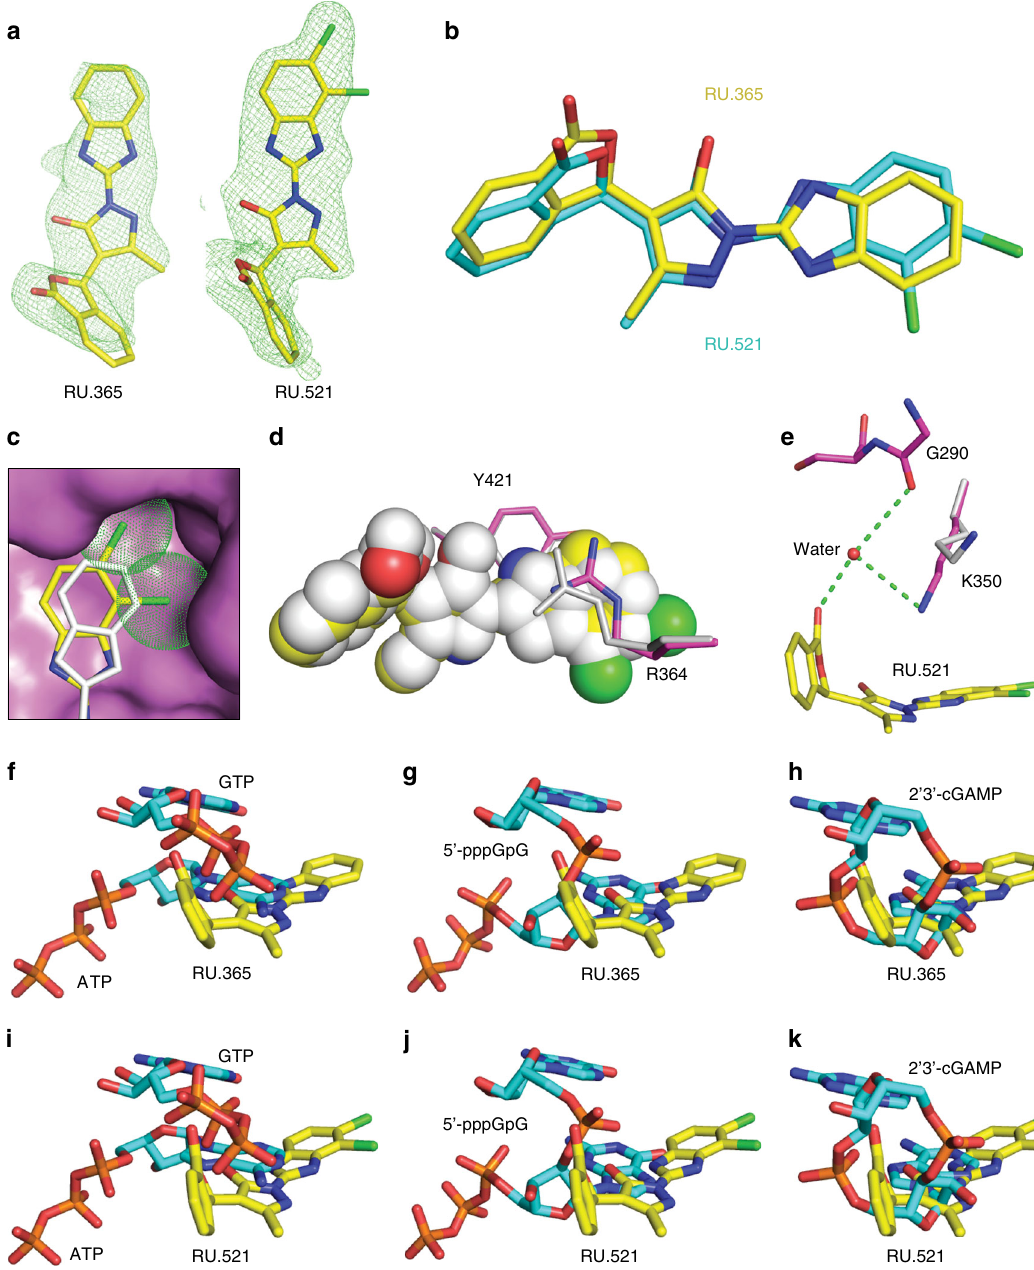
Fig. 3 A structural comparison of RU.365 with its derivative RU.521. a Omit Fo-Fc electron density ( green mesh ) of RU.365 and RU.521 contoured at 3 σ . b Superposition of structures of bound RU.365 ( yellow ) and RU.521 ( cyan ). c The dichloro substitution target deeper in the cGAS pocket. RU.521 ( yellow ) and RU.365 ( silver ) are shown in stick , with two chlorines shown in dots . cGAS ( violet ) is shown in surface view . d The stacking interaction between RU.521 ( yellow )/RU.365 ( silver ) and R364/Tyr421. e Water-mediated interaction between RU.521 ( yellow ) and cGAS ( violet ). Lys350 in RU.365 complex is shown in silver . Superposition of structures of bound RU.365 f – h and RU.521 i – k with those of substrates, intermediate, and product. All the ligands are shown in stick representation. Inhibitors are shown in yellow . Substrates/Intermediate/Product are shown in cyan